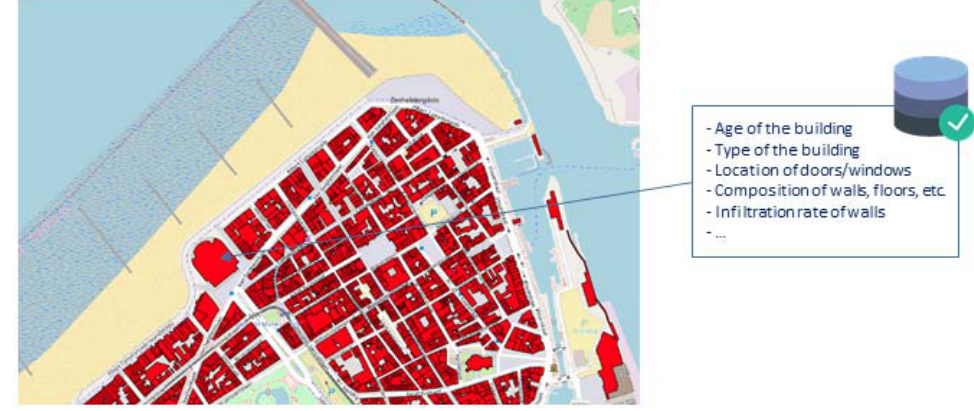
Figure 7. The Flood Impact Assessment Tool (FLIAT) comes with a relational database that can embed a variety of detailed data